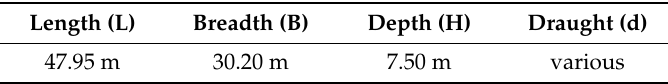
Table 1. Key geometrical parameters of the protective